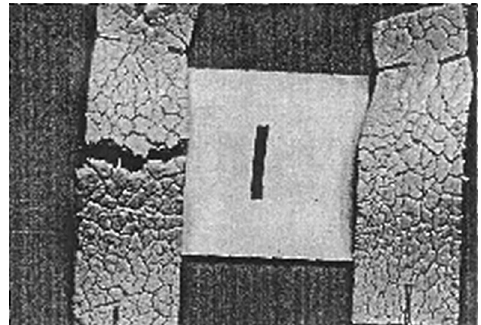
Fig. 6. FMS A (without colouring agent) exposed to UV light and intermittent water spray after 1200